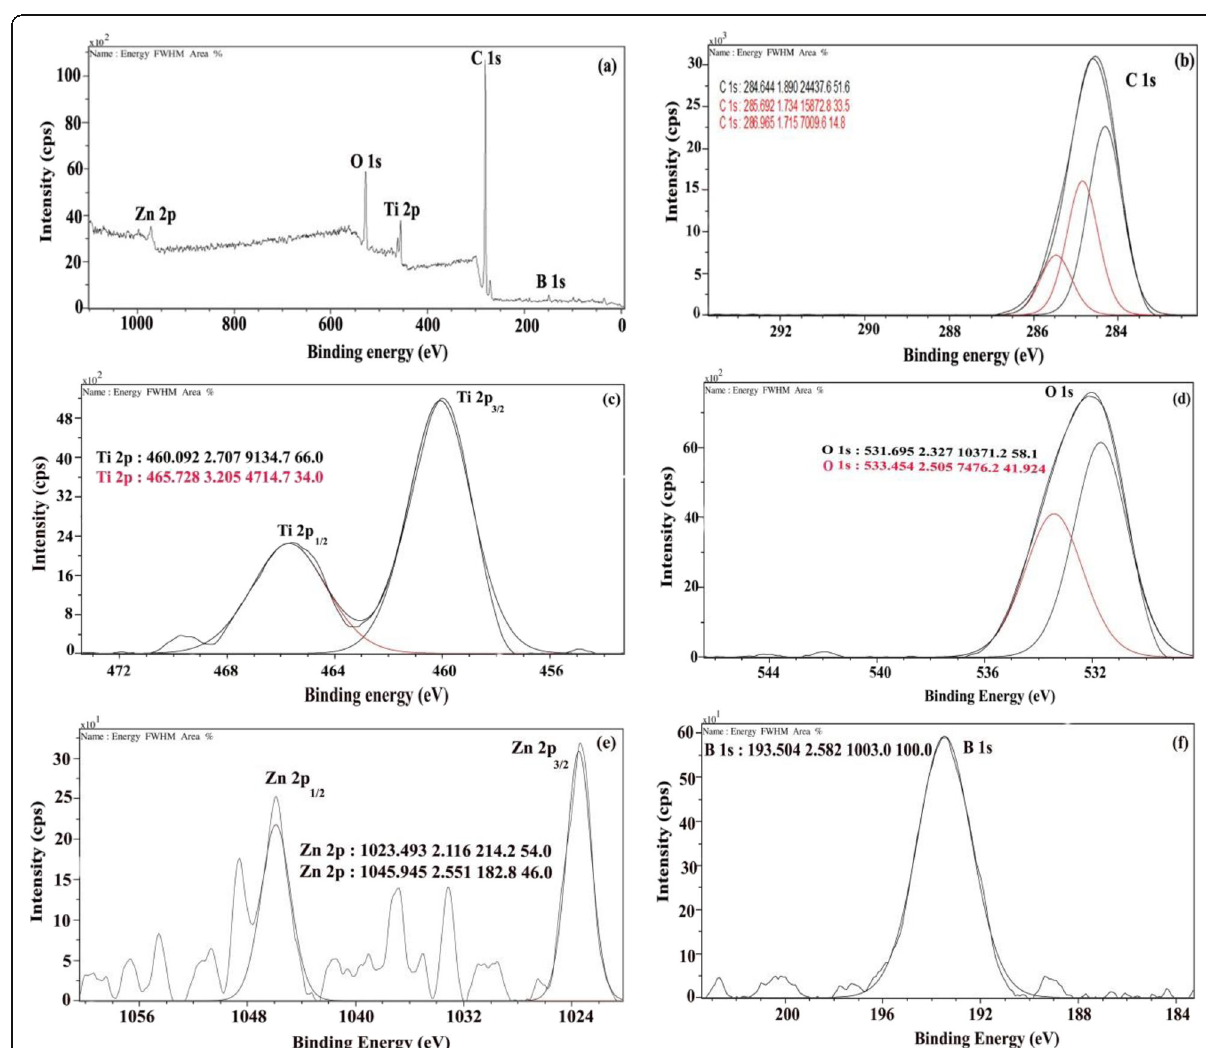
Fig. 2 ( a ) XPS survey spectrum of co-doped TiO 2 and high resolution spectrum of ( b ) C 1s ( c ) Ti 2p ( d ) O 1s ( e ) Zn 2p ( f ) B